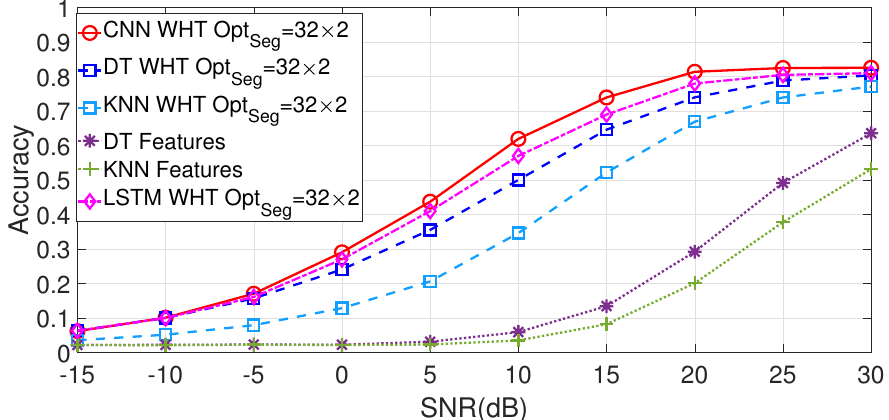
Figure 8. Comparison of the accuracy trends of CNN WHT for Opt seg = 32 ∗ 2 for different values of SNR in dB with the LSTM algorithm, and the DT and KNN algorithms on WHT for Opt seg = 32 ∗ 2, and with the DT and KNN algorithms with the feature based approach.